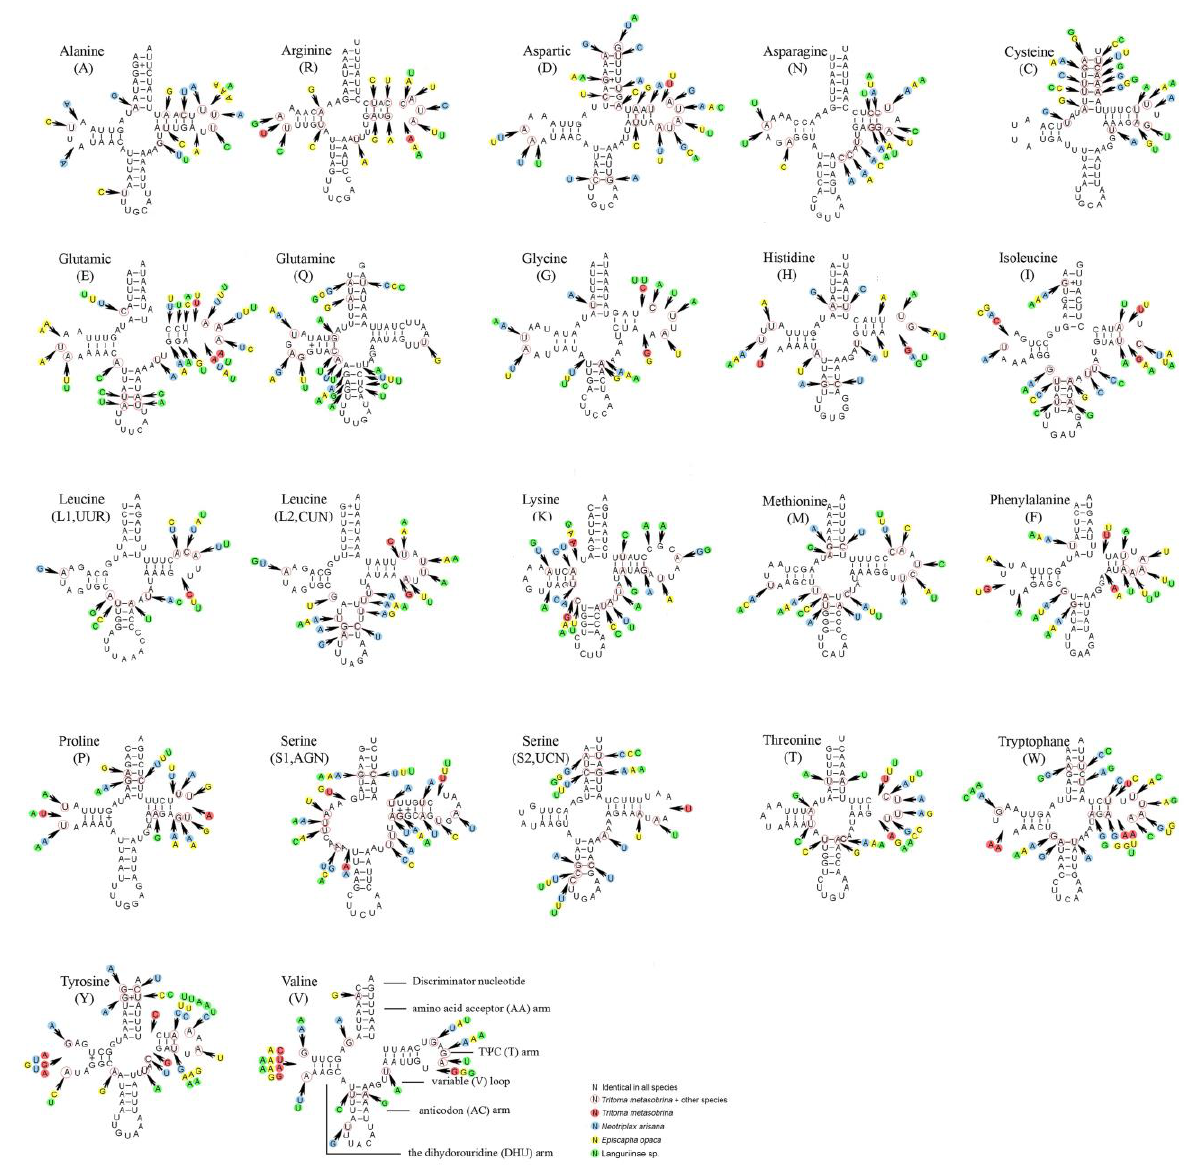
Figure 4. Inferred secondary structures of 22 tRNAs of 4 species. The tRNAs are labeled with the abbreviations of their corresponding amino acids. Dash (–) indicates Watson-Crick bonds and symbol (+) indicates GU bonds. The rrnL was located in tRNA Leu (CUN) and tRNA Val , and its length ranged from 1052 to 1379 bp. The longest rrnL was shown in Languriinae sp. The shortest rrnL was shown in E. opaca . The rrnS was located in tRNA Val and CR in the four mt genomes of Erotylidae with the length ranging from 759 to 777 bp. The shortest rrnS was shown in E. opaca .